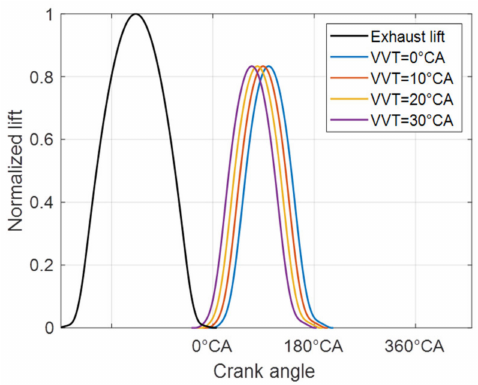
Figure 3. VVT offset effects on the intake lift